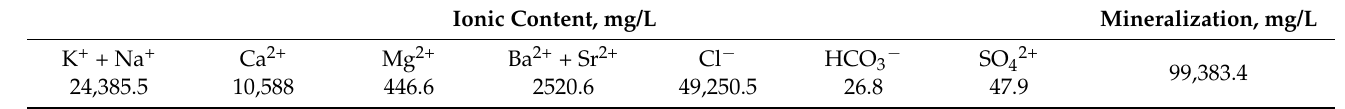
Table 2. Analysis results of ion composition of the produced water samples. Ionic Content, mg/L Mineralization, mg/L K + + Na +